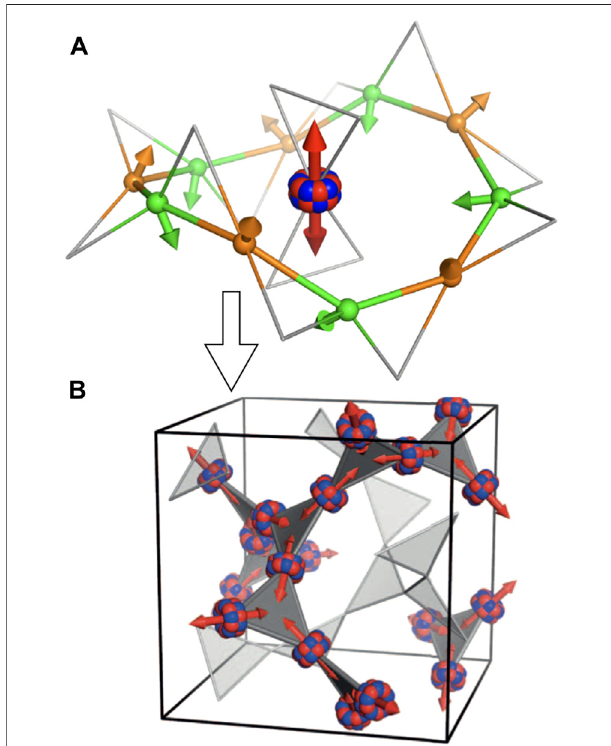
FIGURE 1 | (A) Local spin direction on Gd sites of the ten-ion loop and (B) the resultant staggered magnetisation along the loop, L, represented by the director spin in the center. Correlated director state populated on the garnet lattice [4].